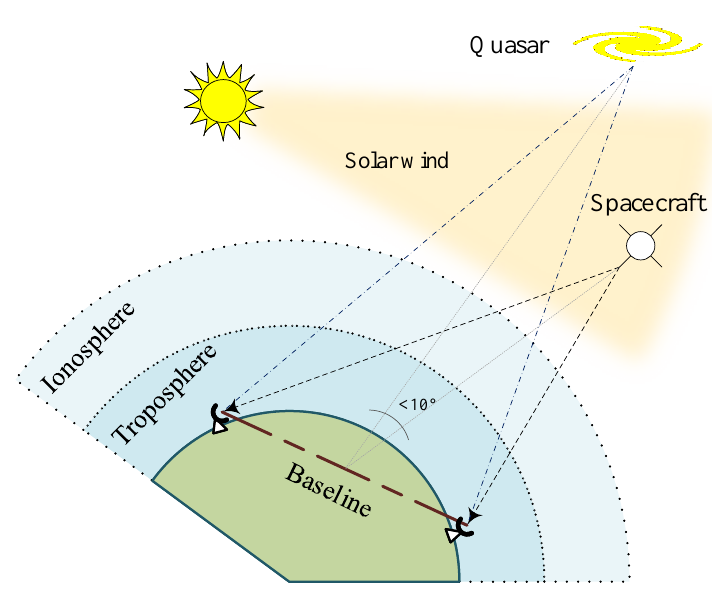
Figure 1. ∆ DOR measurement principle and